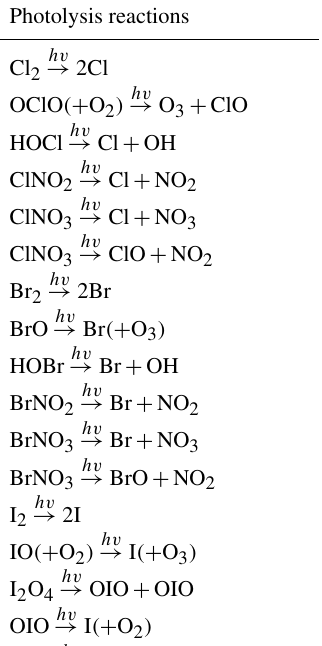
Table 4. Photolytic reactions of halogens included in